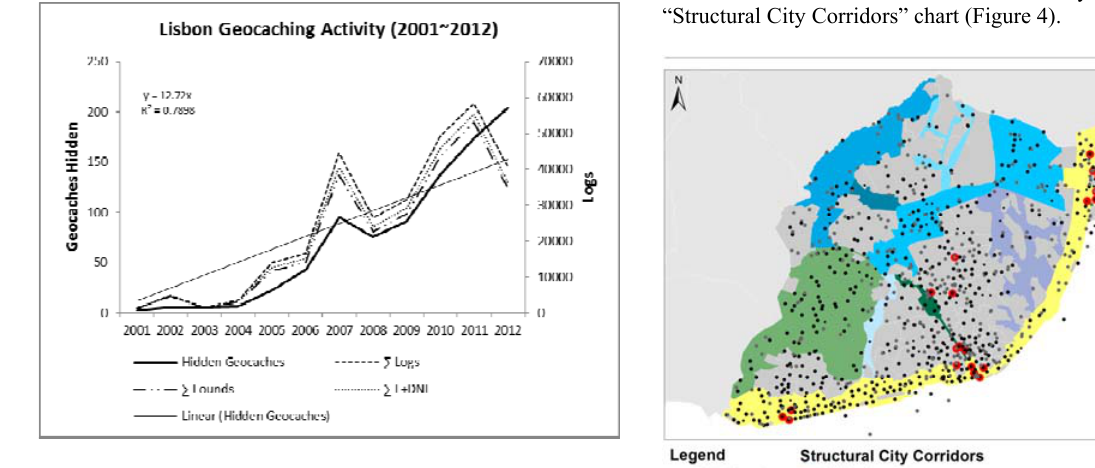
Figure 2. Lisbon Geocaching Activity from 2001 to 2012 regarding the number of caches hidden per year. ∑ of Logs, Founds and Found + Do Not Founds are related to the cache hidden Year. Figure 4. Caches locations regarding Lisbon Structural City Corridors. Special emphasis is made to TOP20 caches.